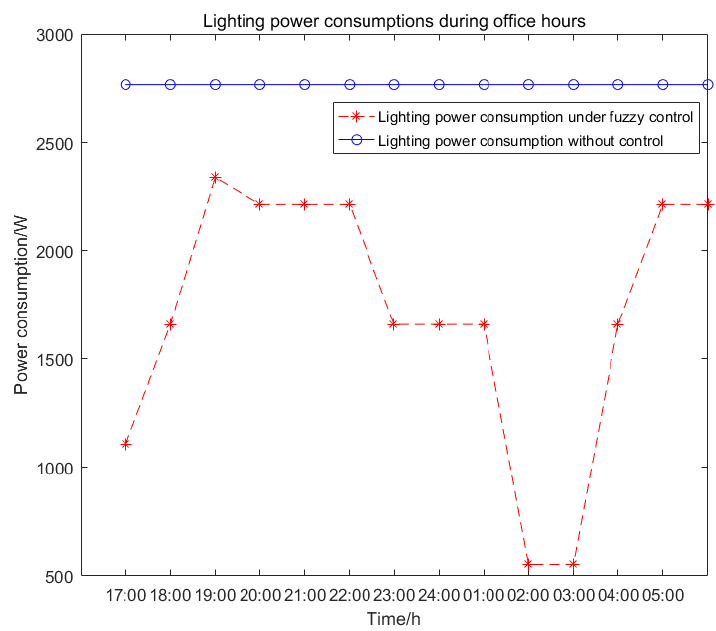
Figure 12. Office lighting power distribution by time